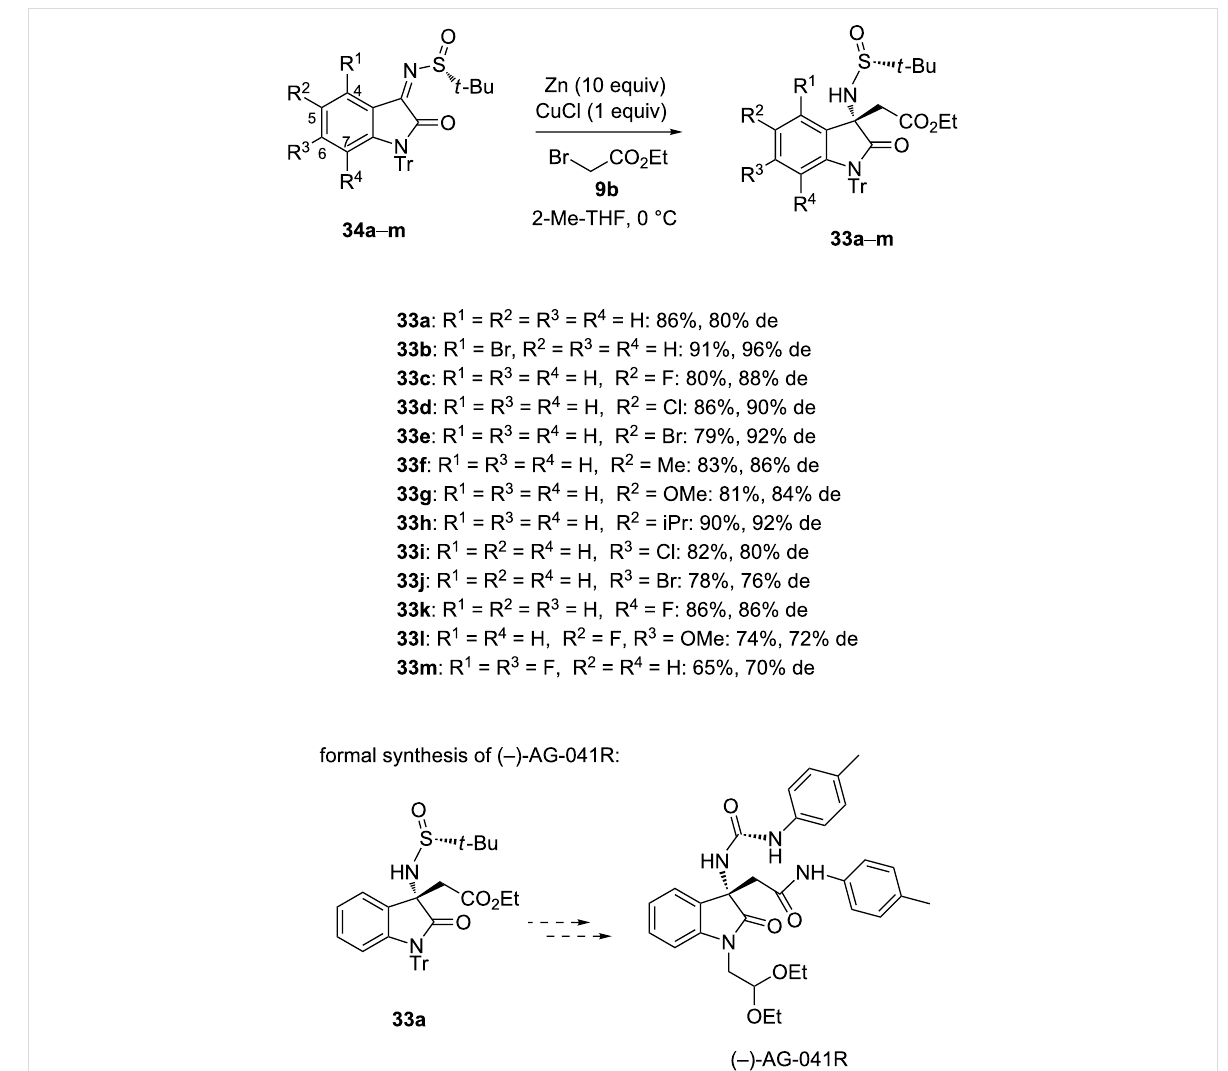
Scheme 13: Synthesis of (2-oxoindolin-3-yl)amino esters through a Zn-mediated aza-Reformatsky reaction